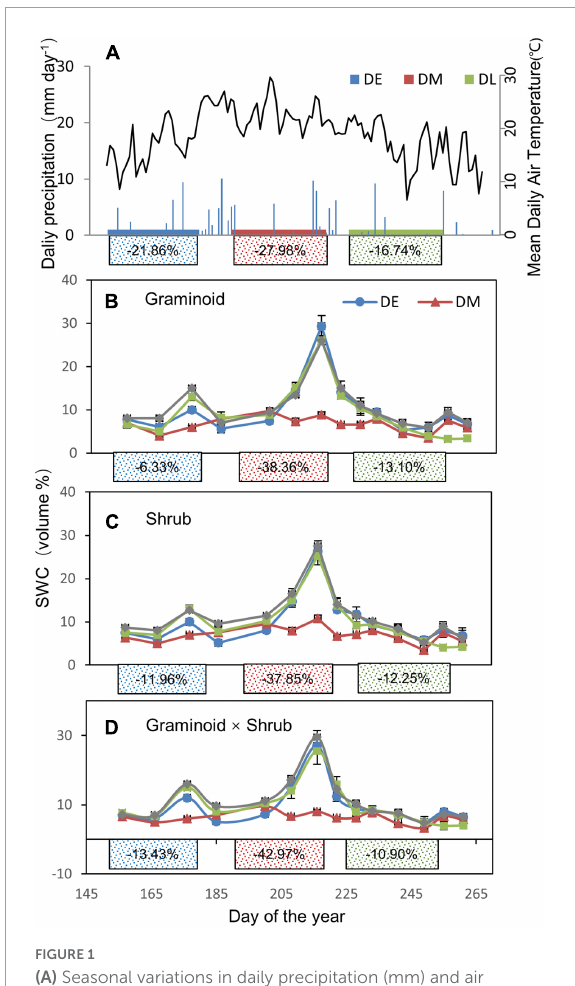
FIGURE1 (A) Seasonal variations in daily precipitation (mm) and air temperature during the growing season of 2017. (B–D) Seasonal changes in soil water content (SWC, volume %) at 0 to 10 cm soil depth in three plant functional types (PFT): graminoids plots (G), shrub plots (S), and graminoid × shrub plots (GS) during the growing season in 2017, respectively. Shades (A) or lines (B–D) of blue, red, and green correspond to the drought treatment occurring in the early- (DE), mid- (DM), and late stage (DL) growing season, respectively. The solid rectangles indicate the occurring time of different extreme drought treatments (no effective rainfall 30 days’ interval). The numbers in the solid rectangles represent the mean decreased rainfall (A) and soil moisture (B–D) of each drought period compared with the corresponding ambient condition over the whole growing season,